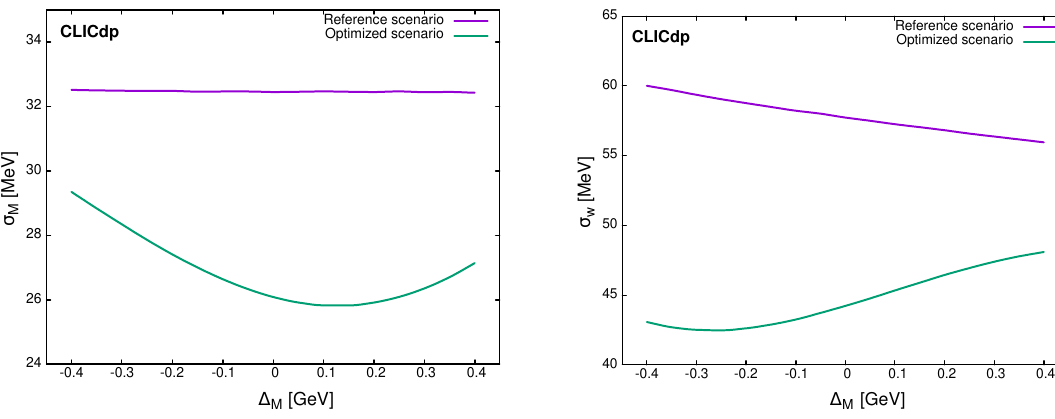
Figure 16 . Dependence of the top-quark mass (left) and width (right) uncertainties from the 5D fit on the initial top-quark mass shift relative to the nominal mass assumed in the optimisation procedure. Compared are results obtained for the reference scan scenario and the scenario optimised for mass and with